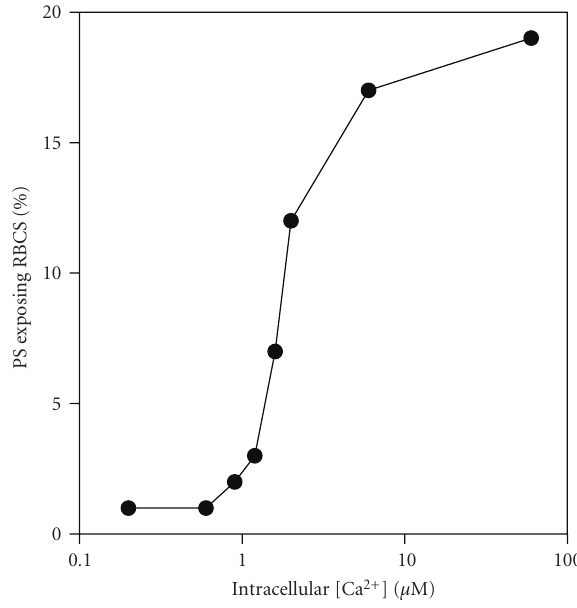
Figure 4: E ff ect of manipulation of intracellular Ca 2+ on phos- phatidylserine (PS) exposure in red blood cells (RBCs) from sickle cell patients. RBCs were first treated with vanadate (1mM) to inhibit the plasma membrane Ca 2+ pump and also the aminophos- pholipid translocase (flippase) before addition of bromo-A23187 (1.2 μ M, 1% haematocrit) and requisite extracellular [Ca 2+ ]s for 30min. They were then treated with Co 2+ (0.4mM) before labelling with FITC-annexin. Intracellular [Ca 2+ ] is calculated from extracellular [Ca 2+ ] × r 2 , where r 2 was taken as 2.05 [36]. Results presented are from a single experiment representative of 5